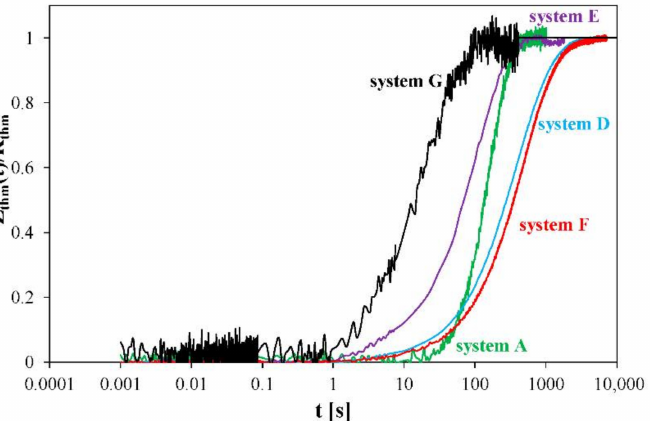
Figure 15. Transfer-transient thermal impedances normalised to transfer thermal resistance of the investigated MOSFETs for the investigated cooling